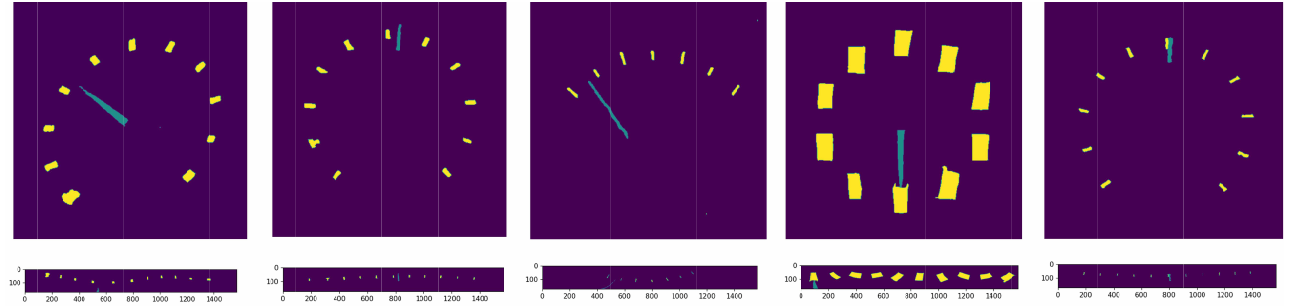
Figure 8. The result of flattening the image.